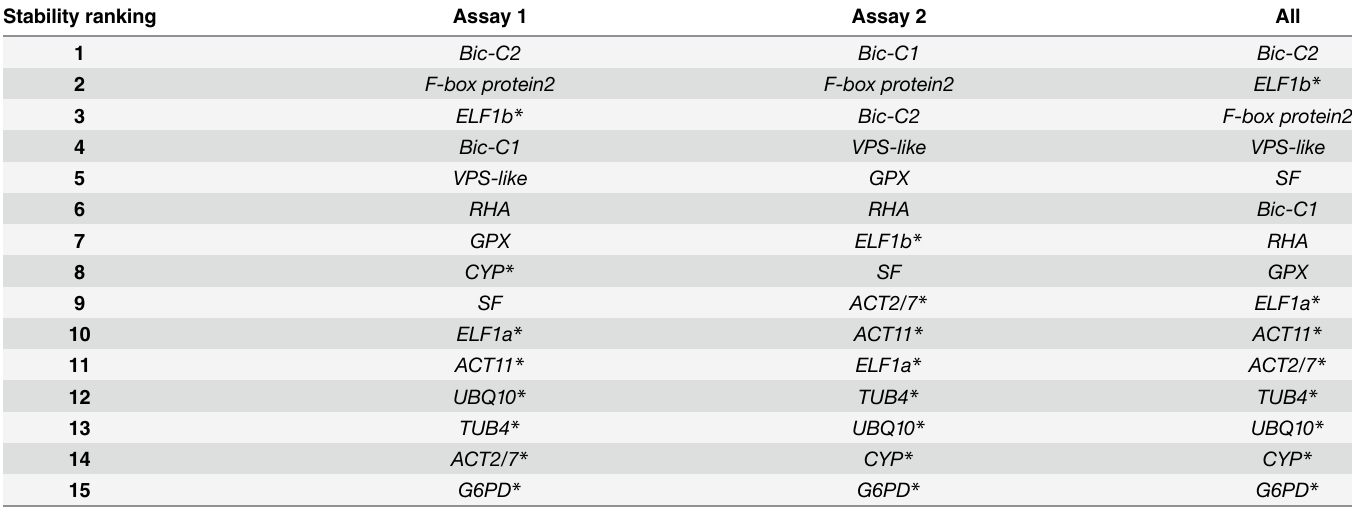
Table 4. Ranking of reference genes based on the geomean of stability